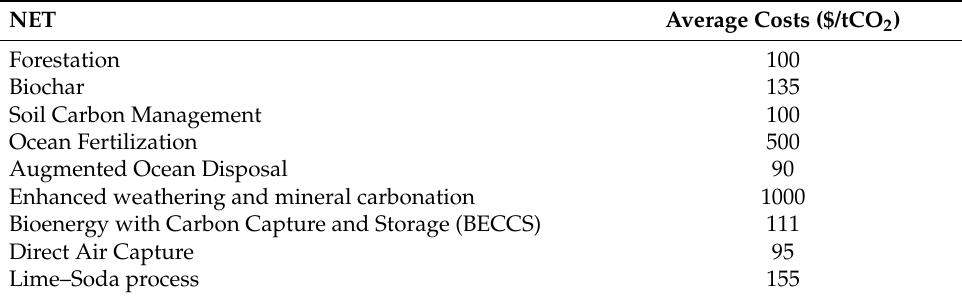
Table 1. Cost indication of the different negative emissions technologies (data from